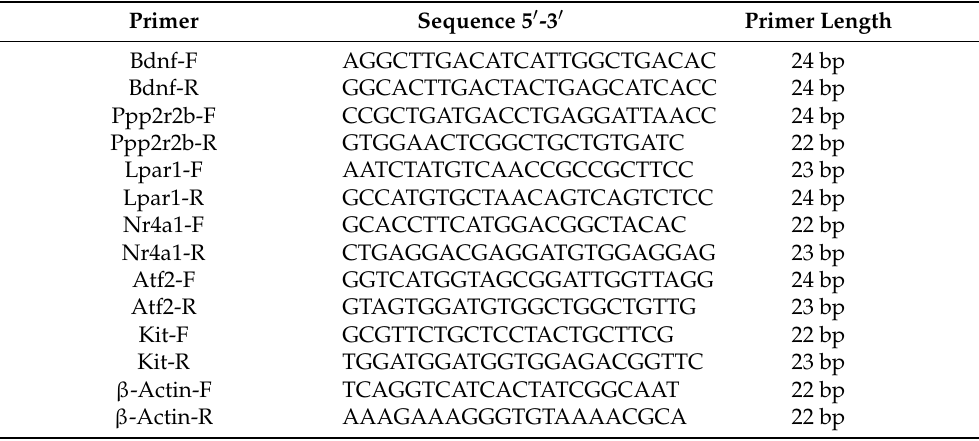
Table 1. Sequences of primer for